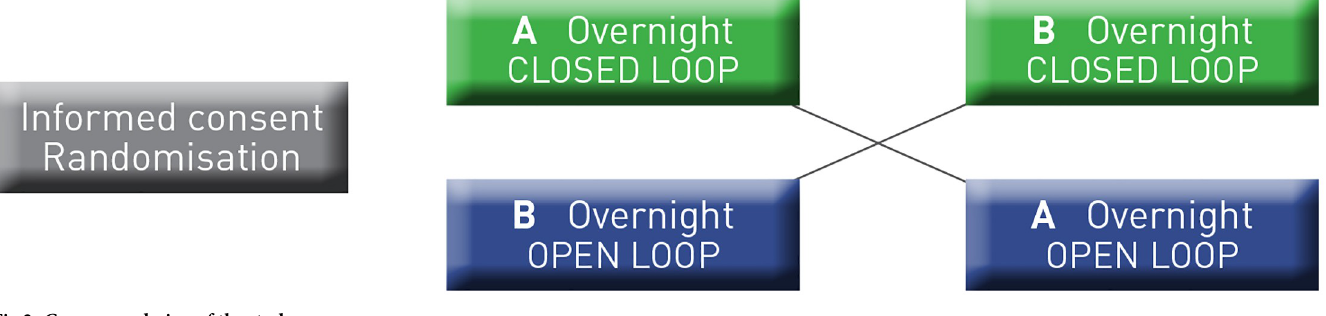
Fig 2. Cross-over design of the